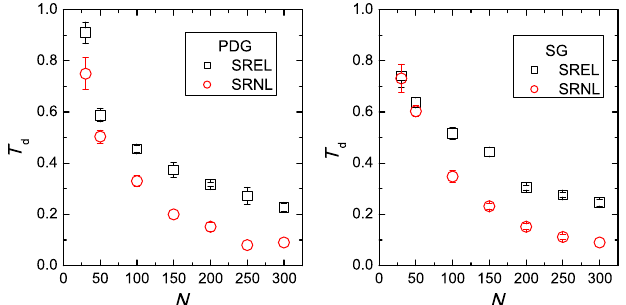
FIG. 2. Threshold data T d of SREL and SRNL for a successful reconstruction as a function of network size N for PDG and SG on scale-free networks, where T d is defined as the amount of data normalized by network size that enables 99% success rate. Each data point is obtained by 10 independent realizations, and the error bars represent standard deviations. The average node degrees of all used networks are fixed to 6. The parameters in the PDG and the SG are b ¼ 1 : 2 , r ¼ 0 : 7 , and (cid:1) ¼ 0 : 1